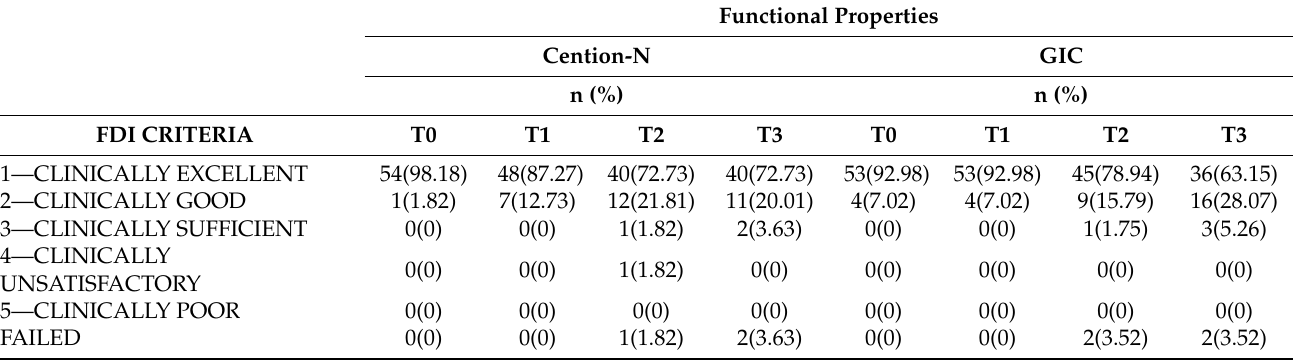
Table 4. Evaluation of functional properties based on FDI criteria. T1 (3 months), T2 (6 months), T3 (12 months). Functional